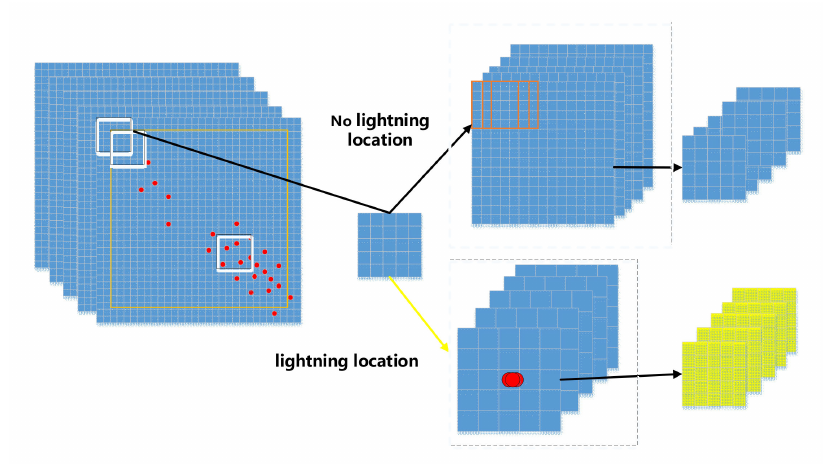
Figure 2. Extraction of feature data with